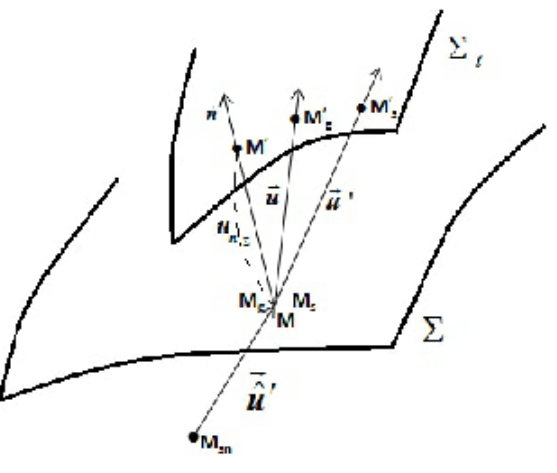
Figure 2. Configuations of Σ and Σ